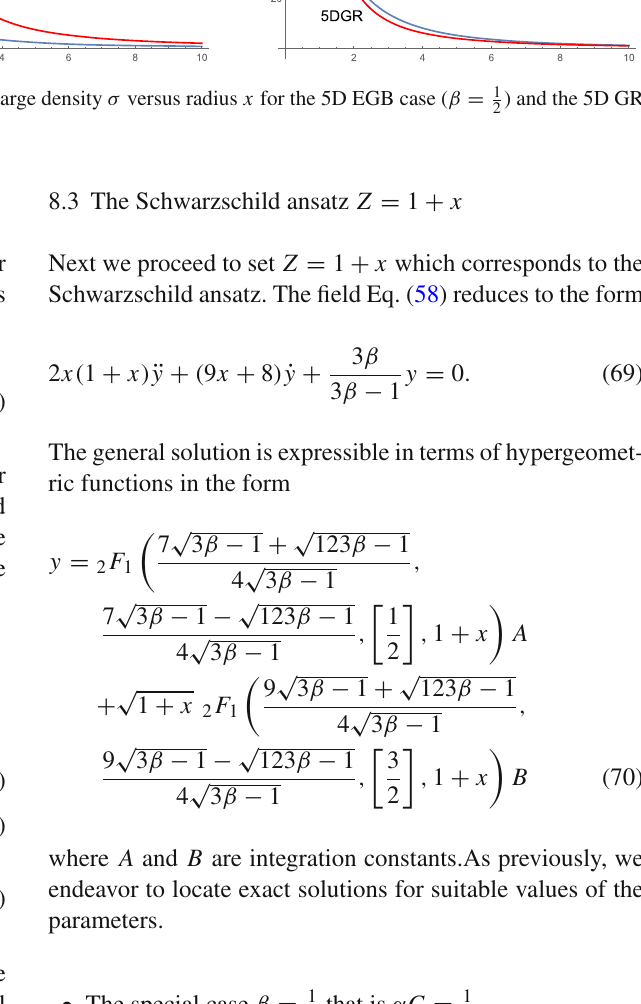
) and the 5D GR 2